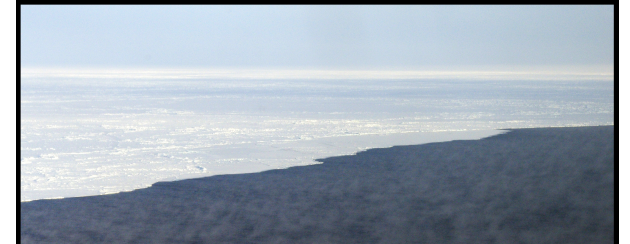
Figure 6. Photograph taken from the MASIN aircraft between legs 3 and 4 during Flight 182 at an altitude of ∼ 100m. The location is marked in Fig. 1.